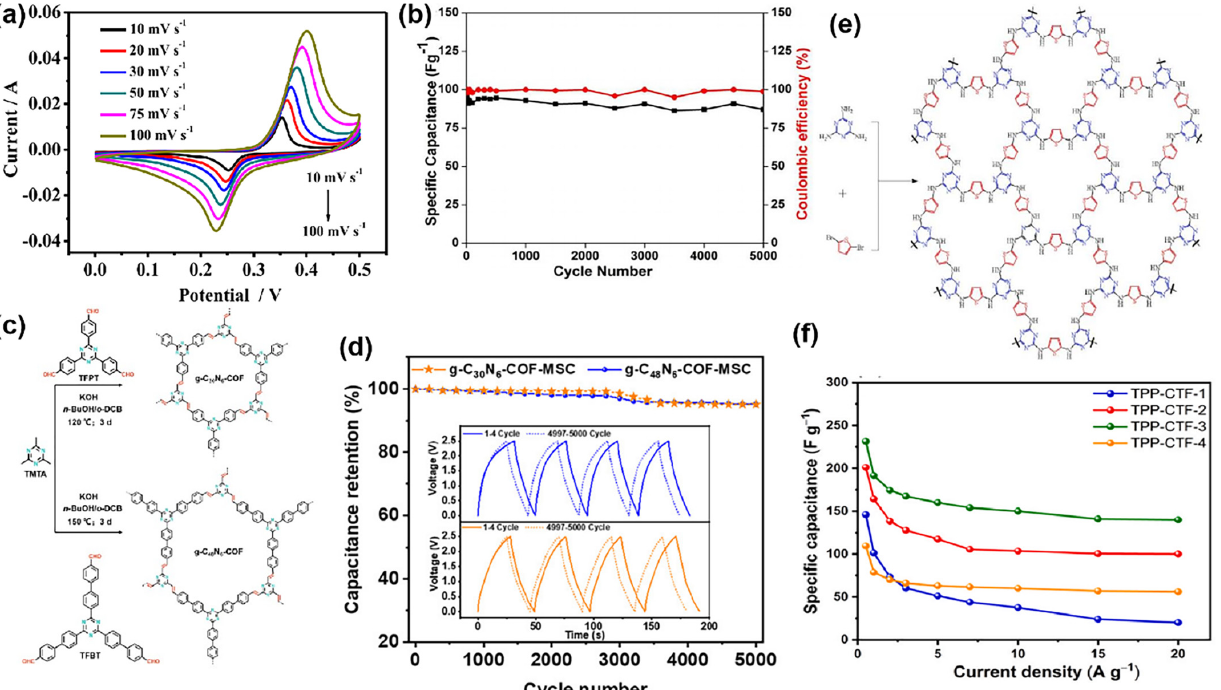
Figure 3. ( a ) CV curves at different scan rates (10, 20, 30, 50, 75, and 100 mV s − 1 ) with